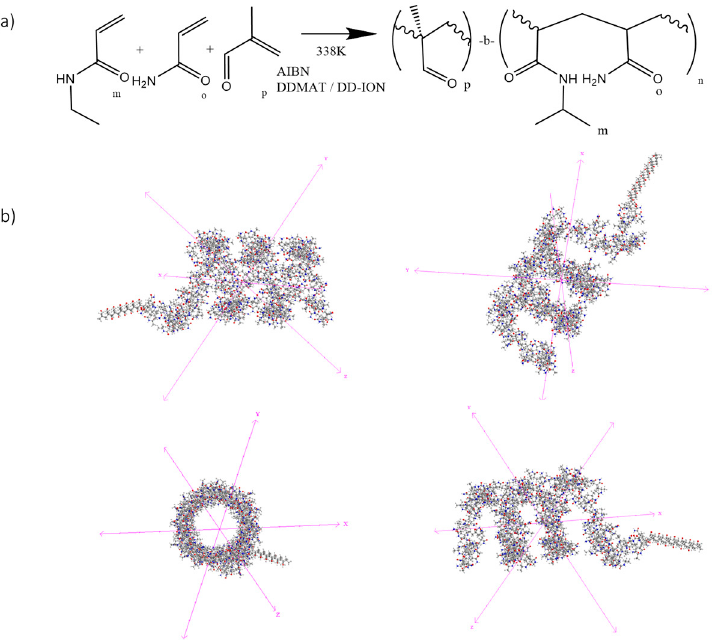
Figure 1. Polymerization synthesis. ( a ) Process and resulting block structure of the novel copolymer NIPAM–acrylamide–methacrolein. ( b ) The three-dimensional structure of the synthesized copolymer showing distinct block copolymer regions as viewed along different axes. The methacrolein block and the NIPAM–acrylamide coil structure are visible as two distinct regions.